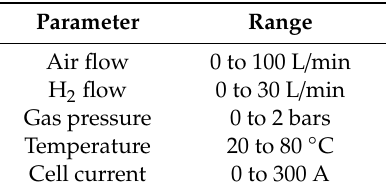
Table 2. Range of parameters